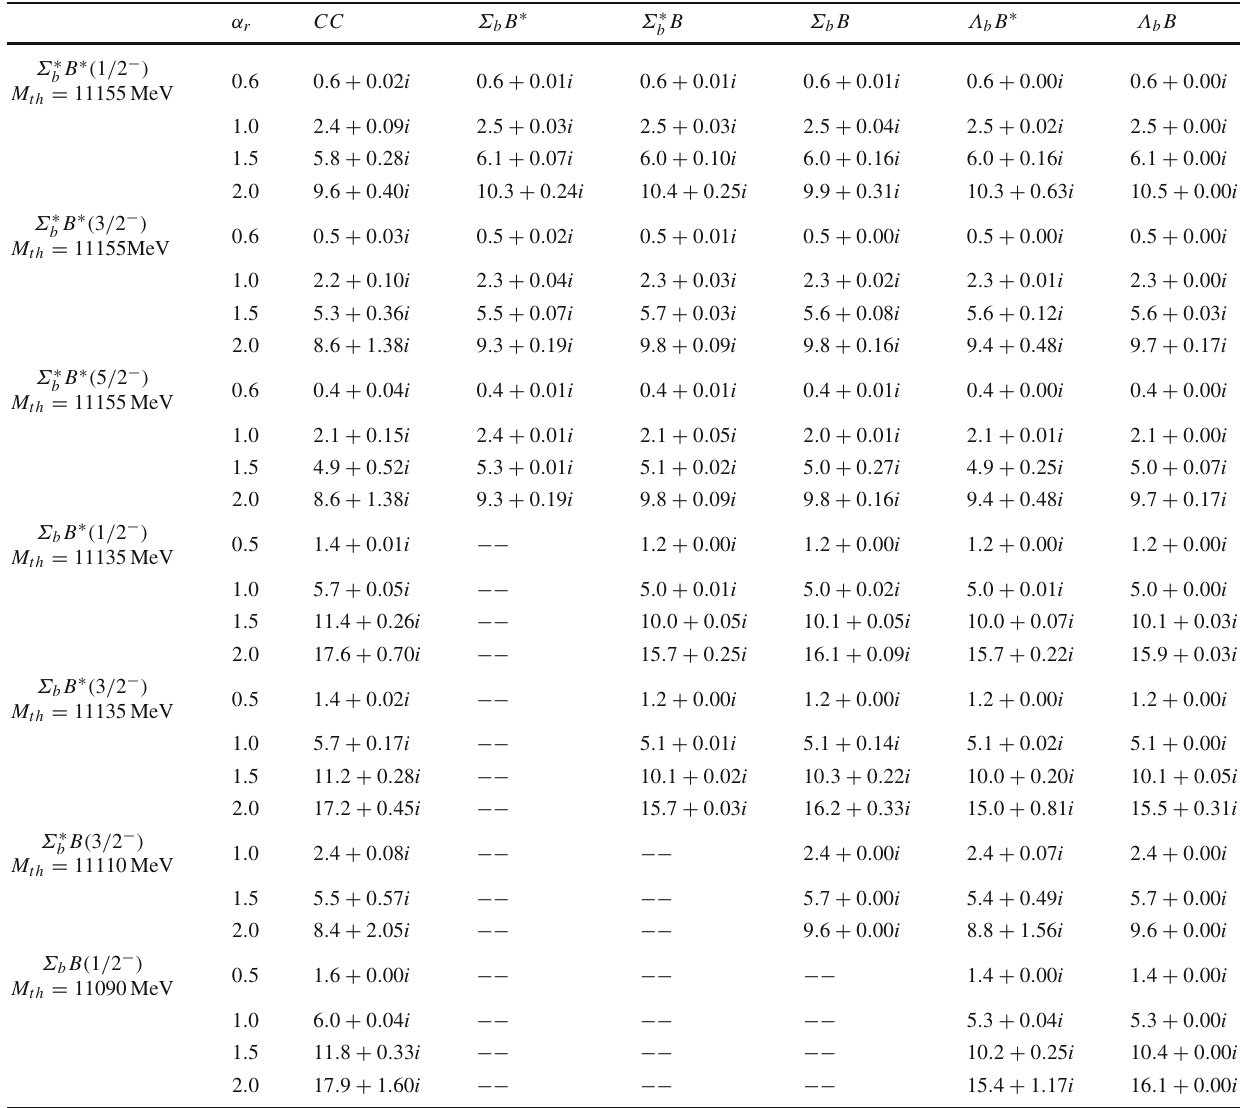
Table 3 The masses and widths of molecular states at different values of α . The “ CC ” means full coupled-channel calculation. The values of the complex position means mass of corresponding threshold sub- tracted by the position of a pole, M th − z , in the unit of MeV. The two